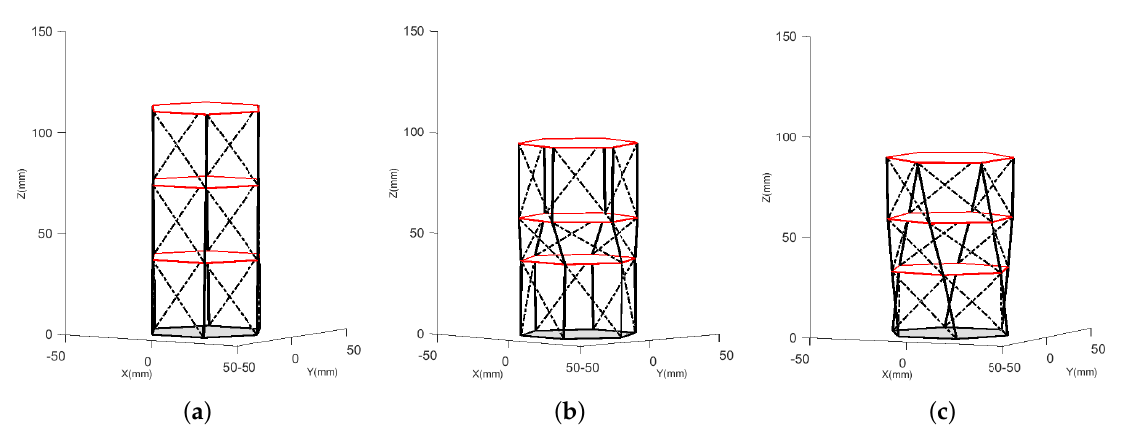
Figure 18. Three-sections link kinematics validation, with parameters α = 38 ◦ , β = 30 ◦ and a = 30 mm. ( a ) Completely deployed link. ( b ) Only one section folding. ( c ) Three sections folding.